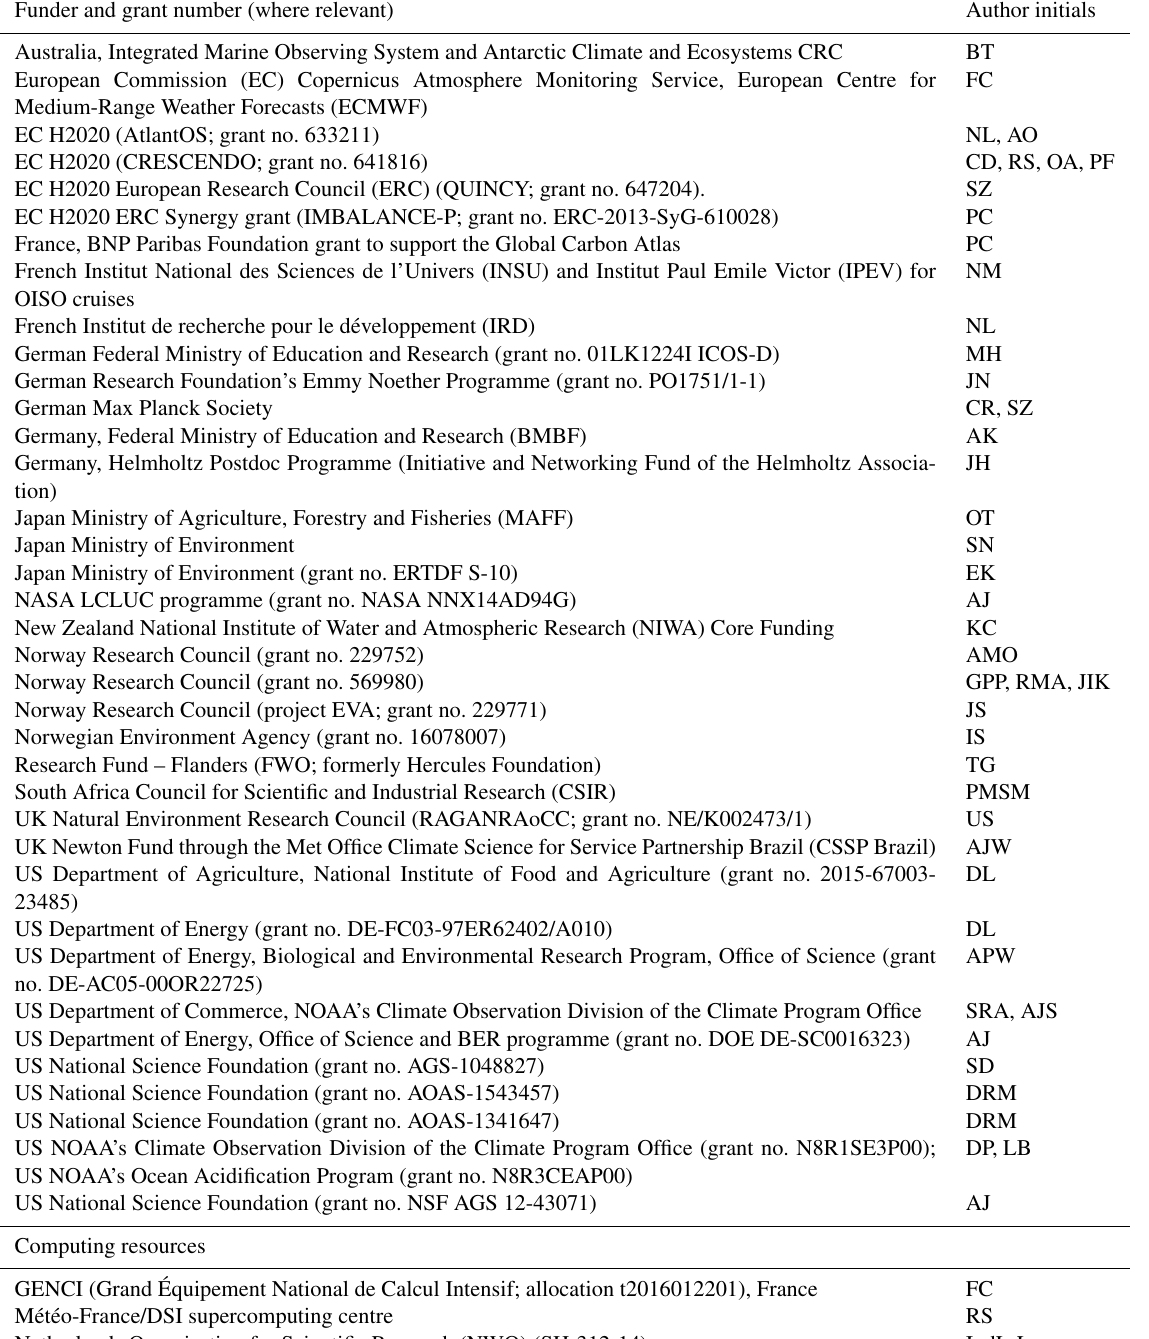
Table B1. Funding supporting the production of the various components of the global carbon budget (see also